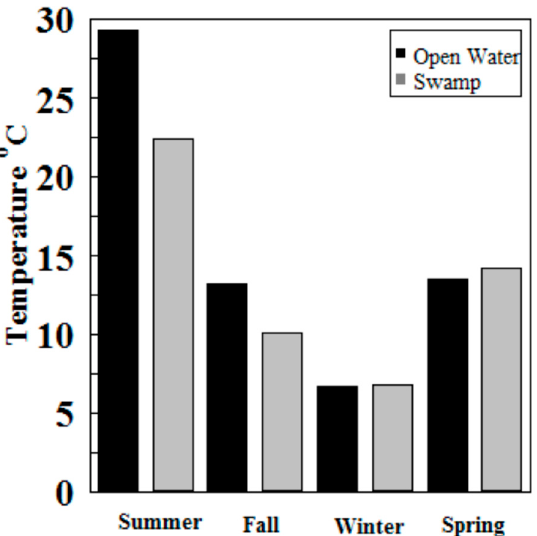
Figure 7. Water temperatures at Sky Lake open water and wetland sites during sampling ( n = 3 per sample).